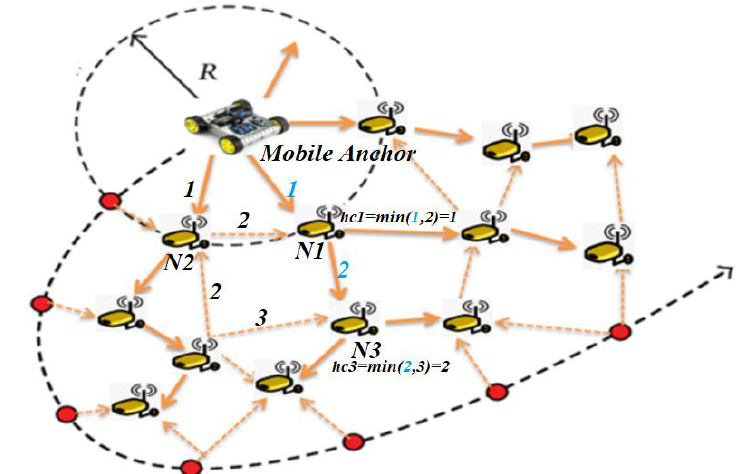
Figure 1. Localization assisted by mobile anchor